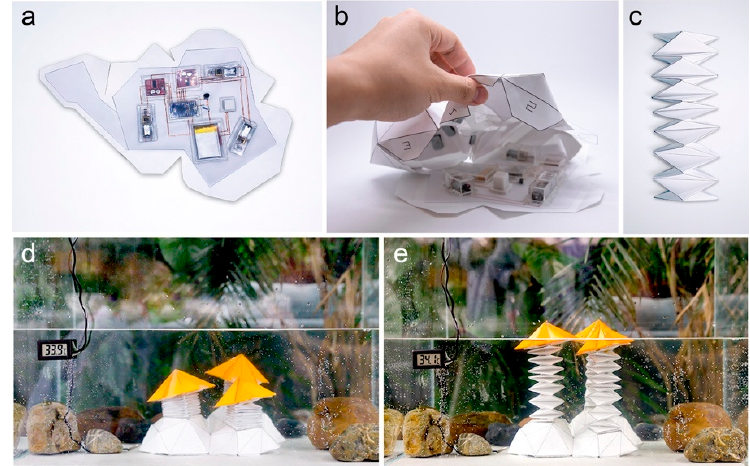
Figure 15. Water temperature sensing. ( a ) Paper circuit; ( b ) inner part of folded Stone structure; ( c ) deployable paper structure; ( d ) the device sits at the bottom when the water temperature drops below 34 °C; and, ( e ) the device rises to the surface when the water temperature exceeds 34 °C.